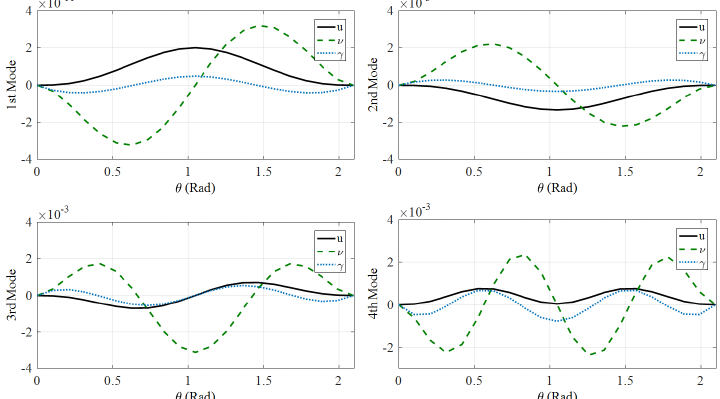
Figure 7. Displacement of nodal points of the curved beam with absorber for the first four modes